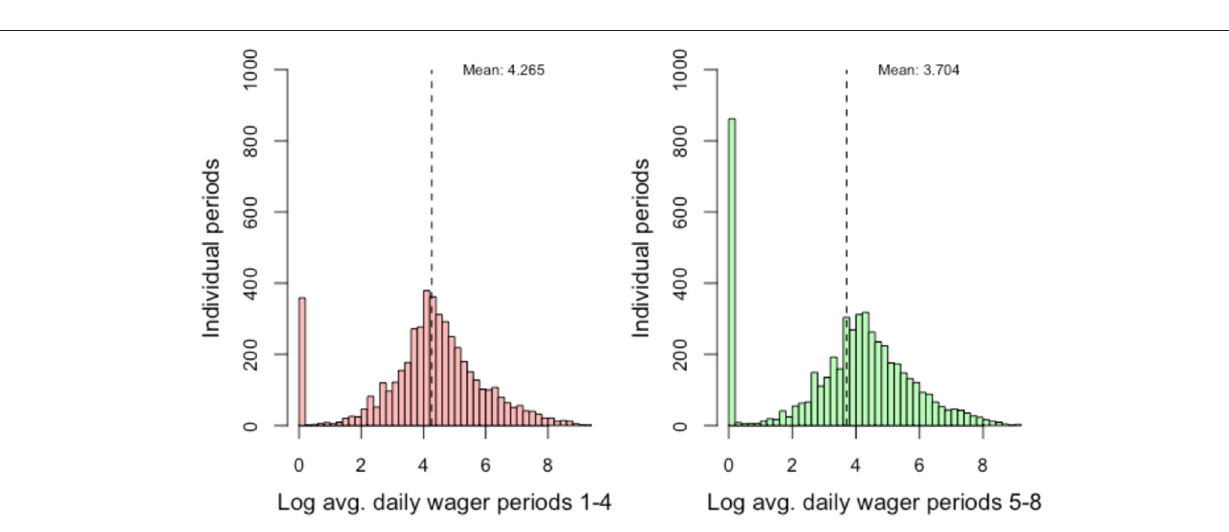
FIGURE 3 | Average daily log wager before (28 days) and after (28 days)